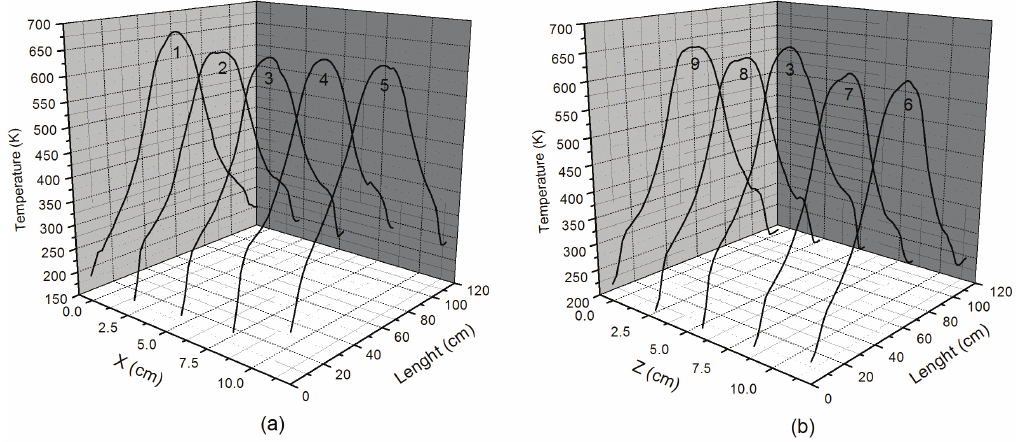
Figure 5. (a) Oven temperature behavior for horizontal and (b) vertical